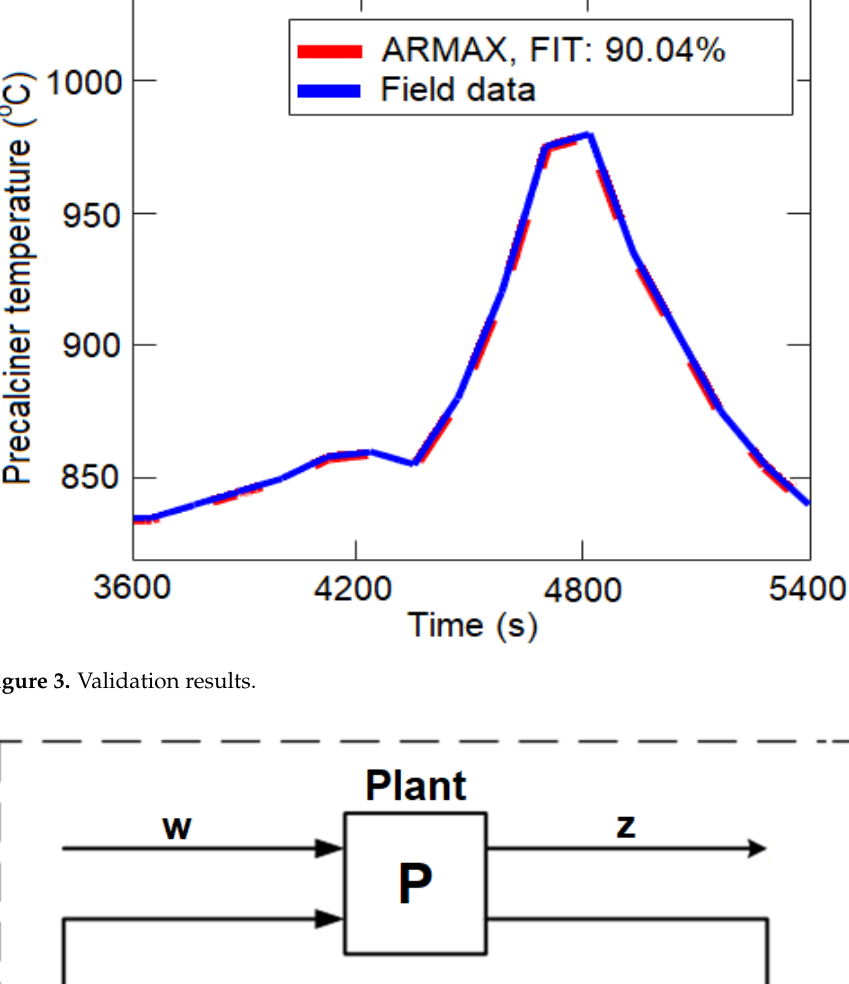
Figure 3. Validation results.